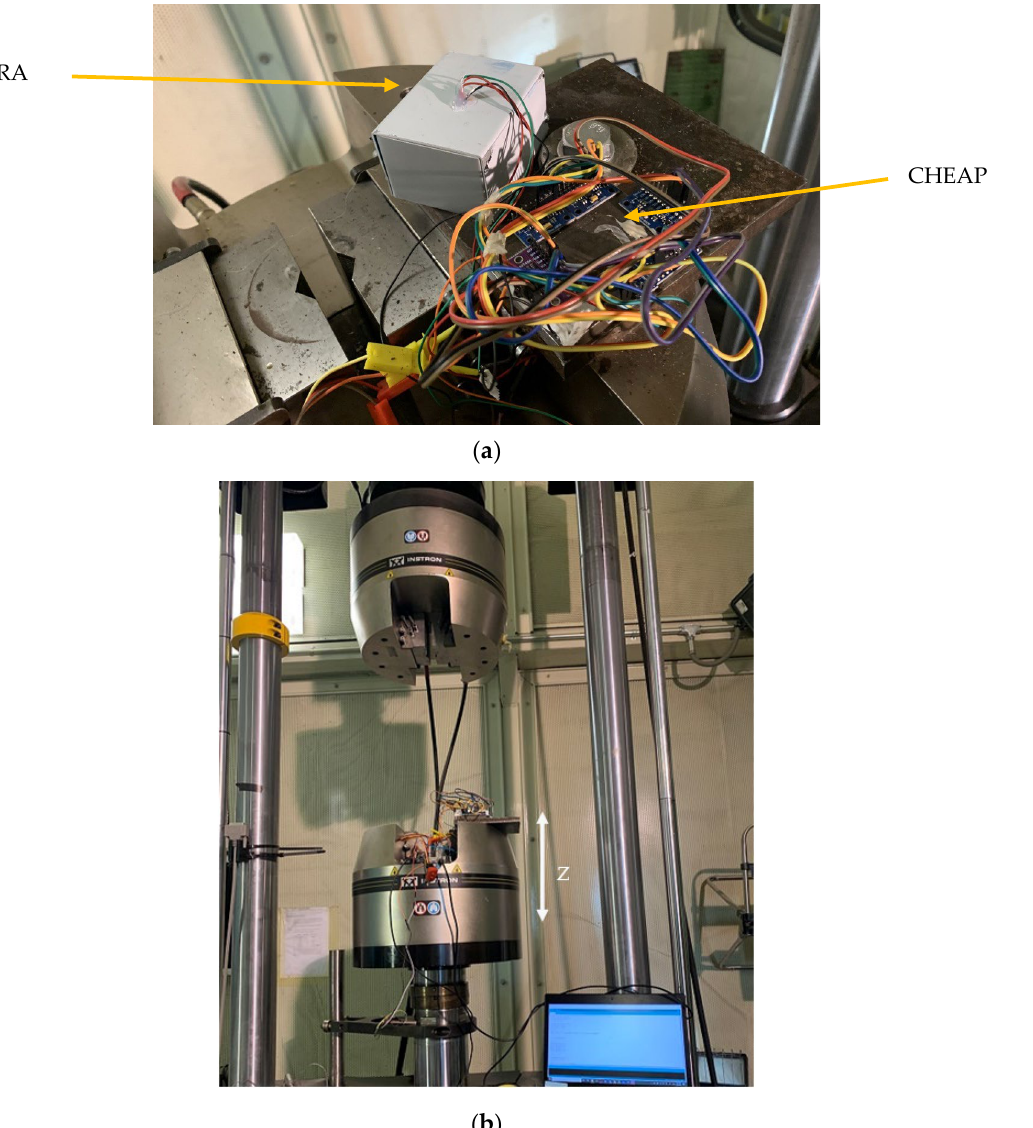
Figure 4. Laboratory validation of LARA: ( a ) mounting CHEAP and LARA to the shaking part of the jack, and ( b ) the used vibrating platform (INSTRON 8803).